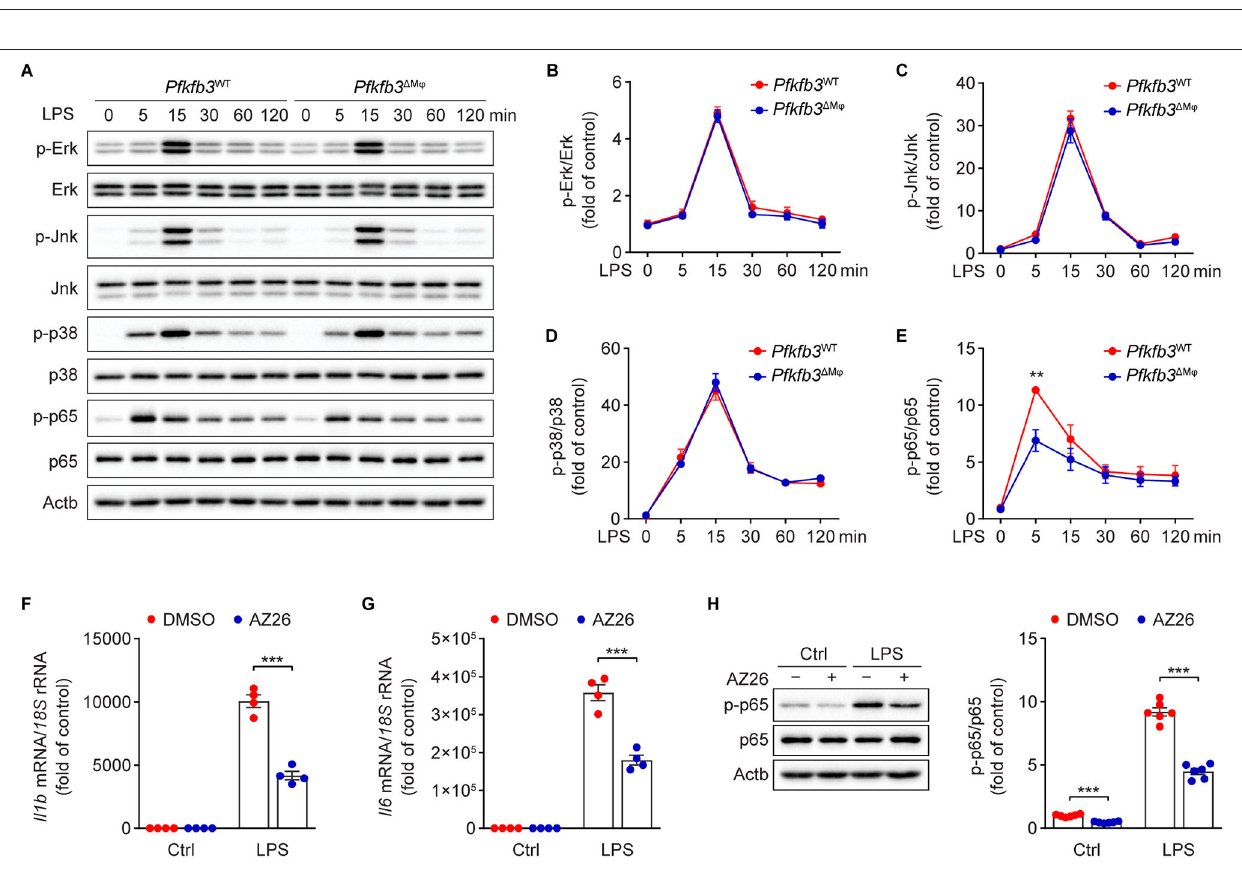
FIGURE 7 | Pfkfb3 inactivation in macrophages suppresses LPS-induced inflammation via the NF- κ B signaling pathway. (A–E) Representative Western blot results (A) of phosphorylated and total level of Erk, Jnk, p38 and p65 in Pfkfb3 WT and Pfkfb3 1 M φ BMDMs treated with LPS (100ng/mL) at the indicated time points, and relative ratio of p-Erk/Erk (B) , p-Jnk/Jnk (C) , p-p38/p38 (D) and p-p65/p65 (E) were quantitated by densitometric analysis of the corresponding Western blots ( n = 4). (F,G) qPCR analysis of the mRNA levels of Il1b (F) and Il6 (G) in BMDMs treated with LPS (100ng/mL) for 4h, with or without AZ26 (10 µ M) pretreatment for 30min ( n = 4). (H) Representative Western blot results (left) of p-p65, p65 and Actb in BMDMs treated with LPS (100ng/mL) for 5min, with or without AZ26 (10 µ M) pretreatment for 30 min, and relative ratio of p-p65/p65 (right) was quantitated by densitometric analysis of the corresponding Western blots ( n = 4). All data are represented as mean ± SEM, ** P < 0.01 and *** P < 0.001 for indicated comparisons (unpaired two-tailed Student’s t